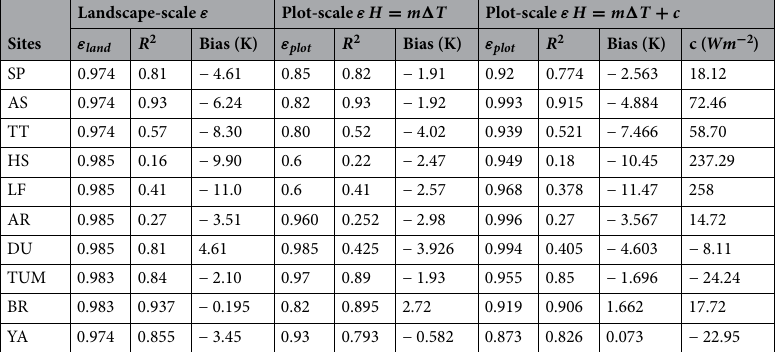
Table 1. Correspondence between daytime landscape-scale LST ( T MODIS ) and plot-scale LST ( T s ) (estimated at TERRA time of pass), using different emissivity. The emissivity values used to retrieve plot-scale LST are either taken from MODIS ( ε land ), or derived from flux tower data ( ε plot ), using Eq. (7) ( H = m (cid:31) T ) or Eq. (8) ( H = m (cid:31) T + c ). The reported ε plot and intercept ( c ) are median values over all months for each site. 2 Bias is defined as the mean of T s − T MODIS , R is the coefficient of determination between plot-scale LST and landscape-scale LST. The site acronyms are explained in Table